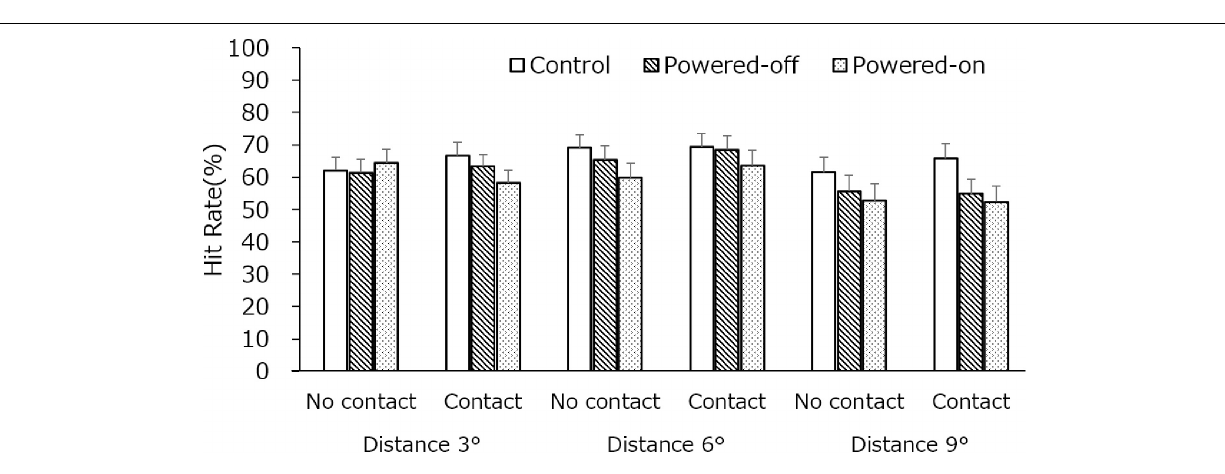
FIGURE 4 | The hit rate of LCD task in experiment 1. Error bars depict standard error